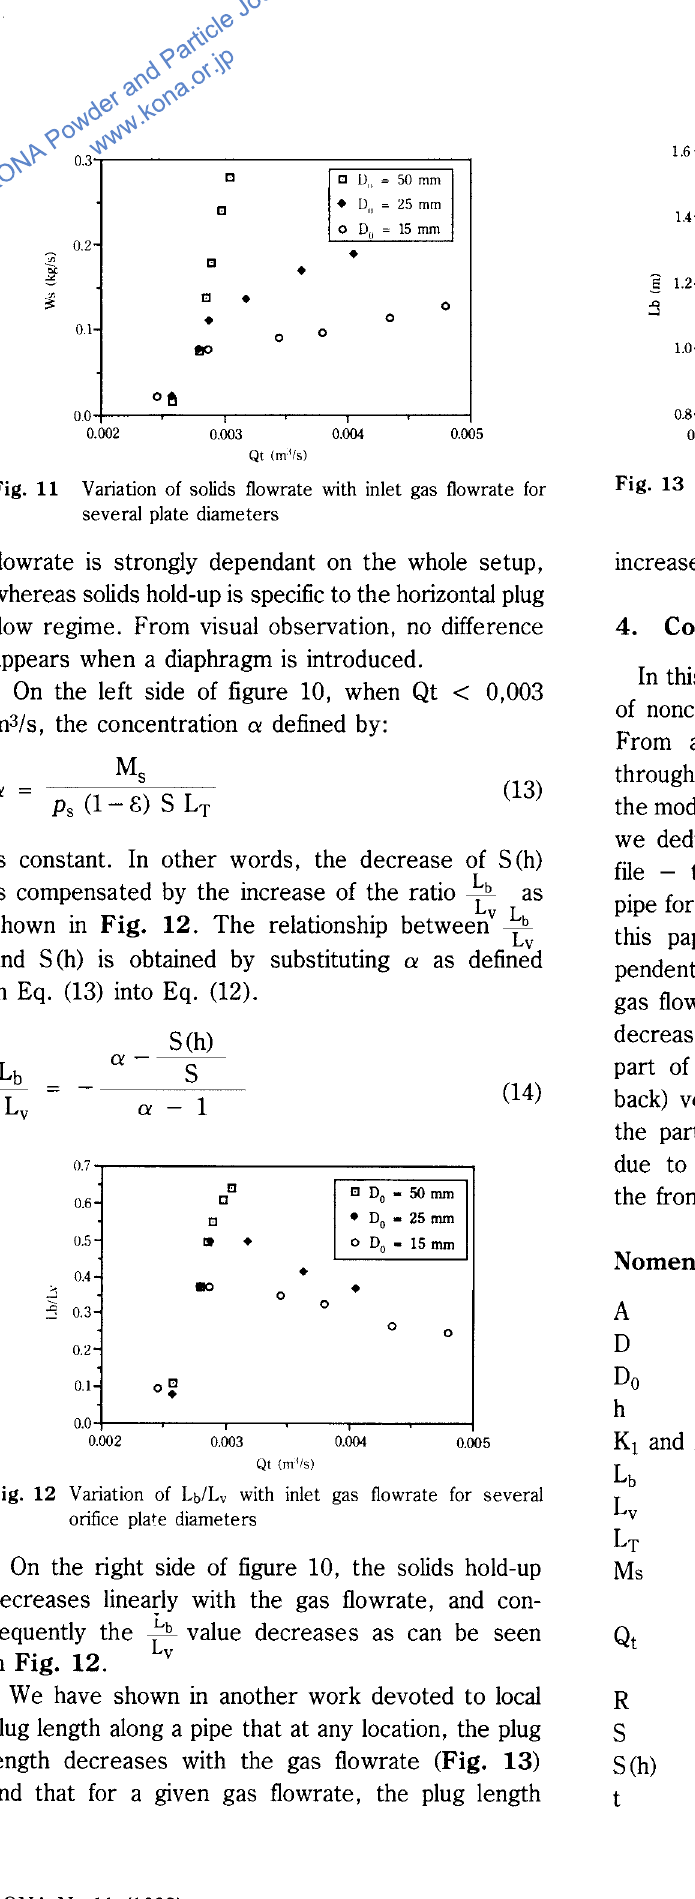
Fig. 12 Variation of Lb/Lv with inlet gas flowrate for several orifice plate diameters